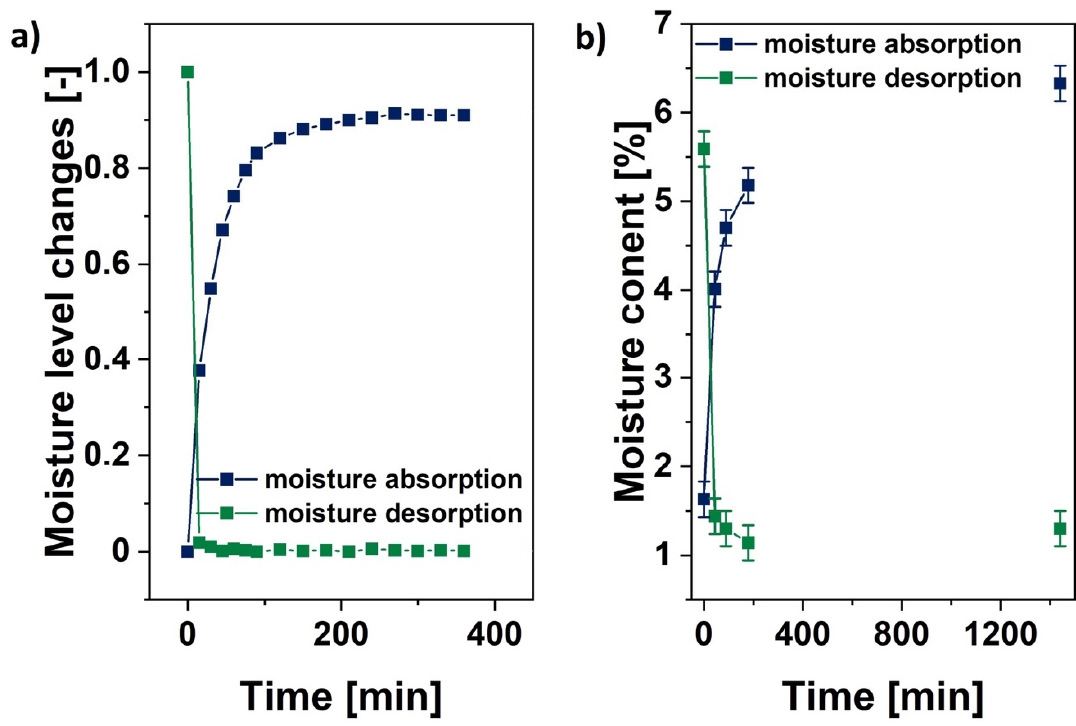
Figure 4. Moisture content changes during the water adsorption and desorption processes. ( a ) Normalized moisture level variations in time according to the sample mass changes and ( b ) Fischer titration experiment results.